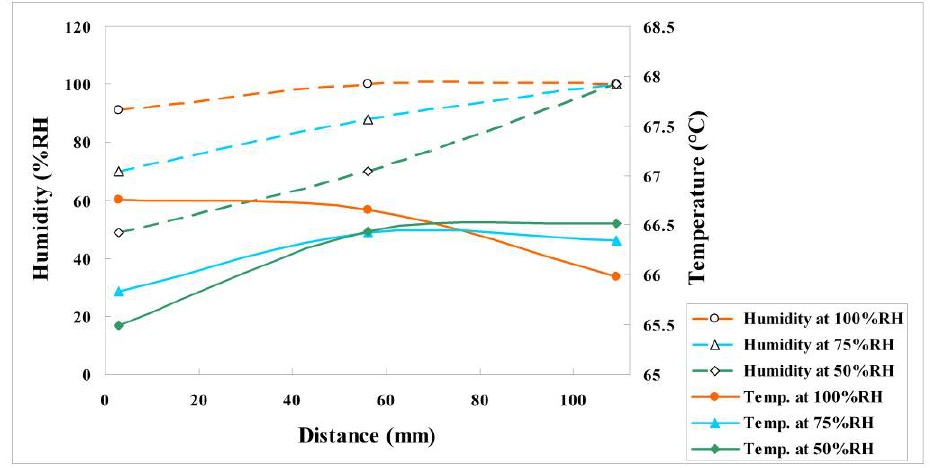
Figure 17. Variation of temperature and humidity at upstream, midstream and downstream (0.5 A/cm 2 ).